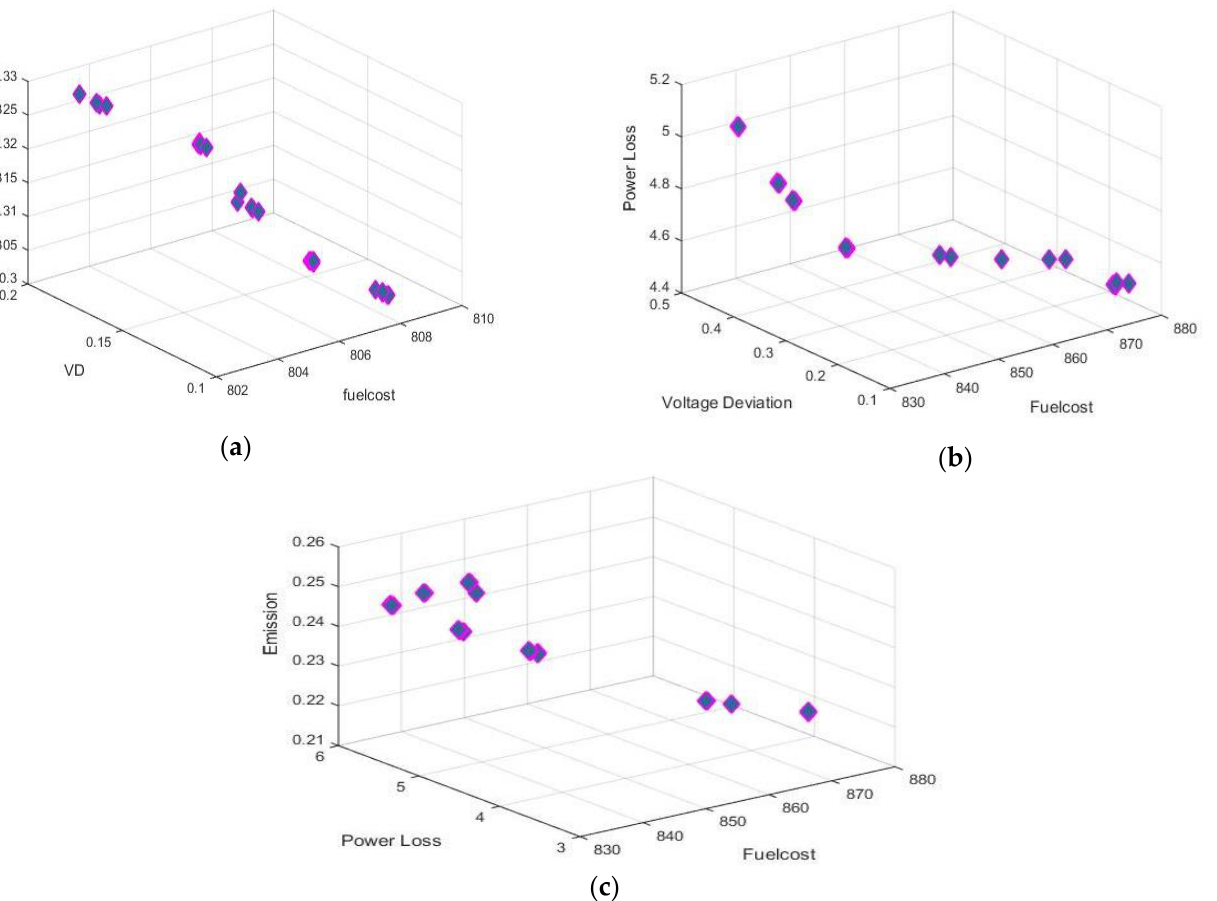
Figure 2. Bi-objective Pareto set of OPF in Cases 6 – 9. ( a ) Case 6; ( b ) Case 7; ( c ) Case 8; ( d ) Case 9.